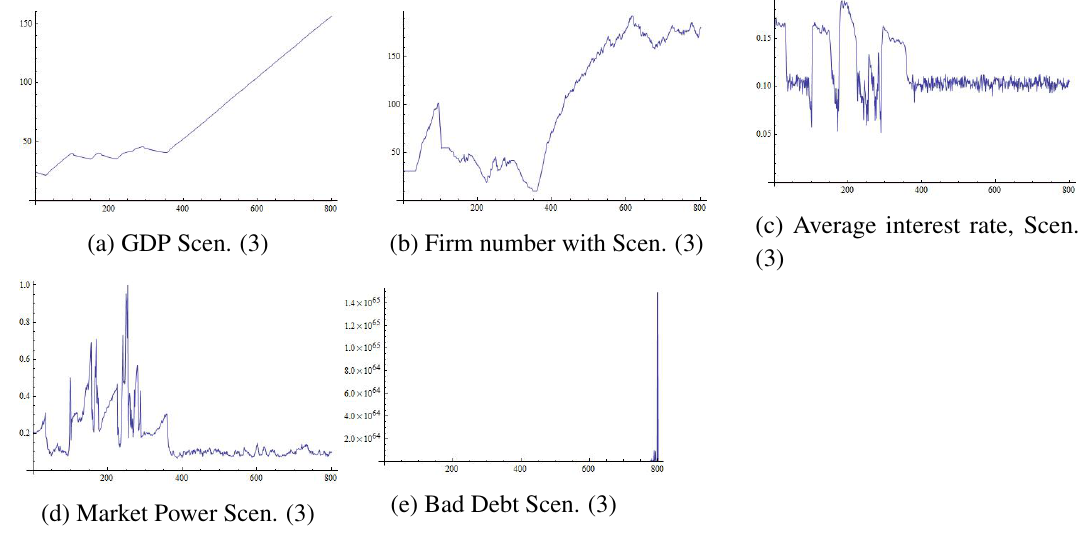
Figure 11: Uncorrelated stock prices ( β high)